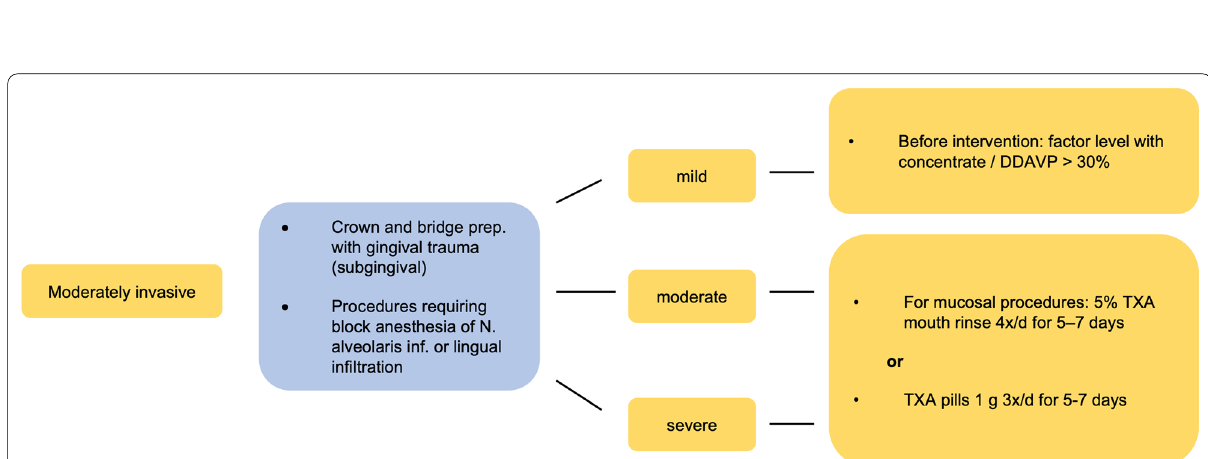
Fig. 2 Exemplary treatment scheme for slightly invasive dental treatments. Low risk (green) and moderate risk (yellow) (acc. to [2]). TXA tranexamic acid, DDAVP desmopressin